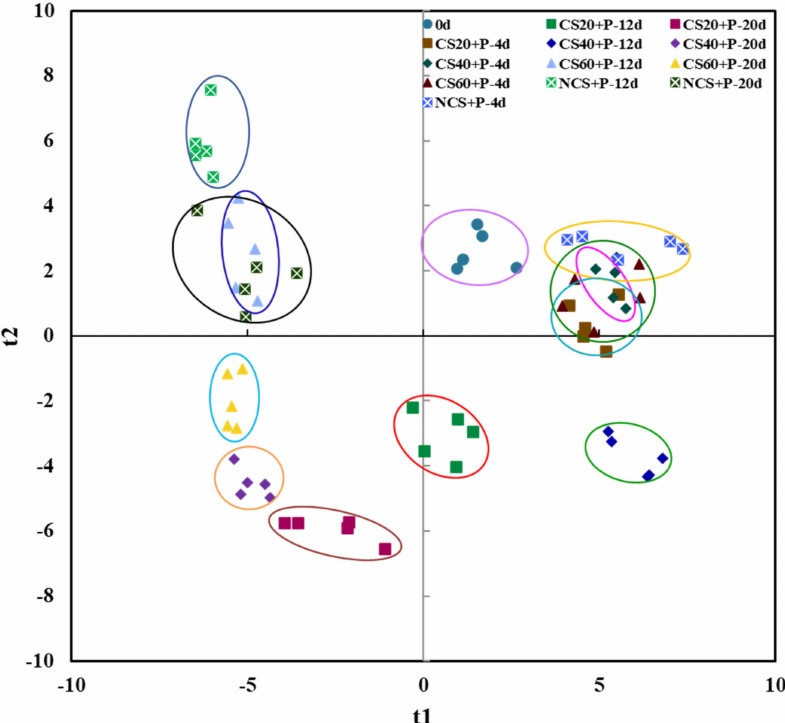
Figure 10. PLS–DA scores of volatile organic compounds in cucumbers under different treatments. CS20+P − packaged after 20 min of cold shock; CS40+P − packaged after 40 min of cold shock; CS60+P − packaged after 60 min of cold shock; NCS+P − packaged after 0 min of cold